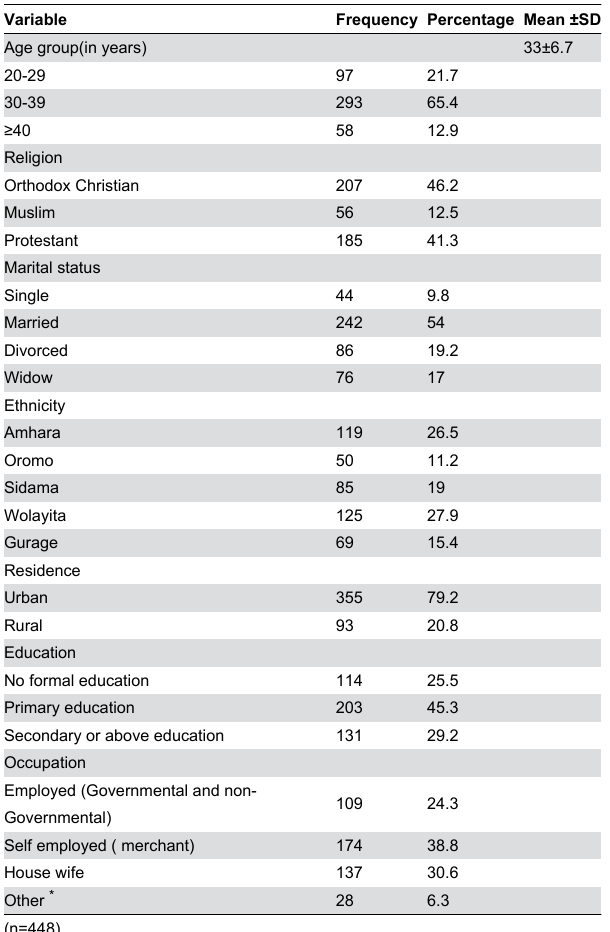
Table 2. Reproductive health characteristics of study participants in the three screening centers, Southern Ethiopia